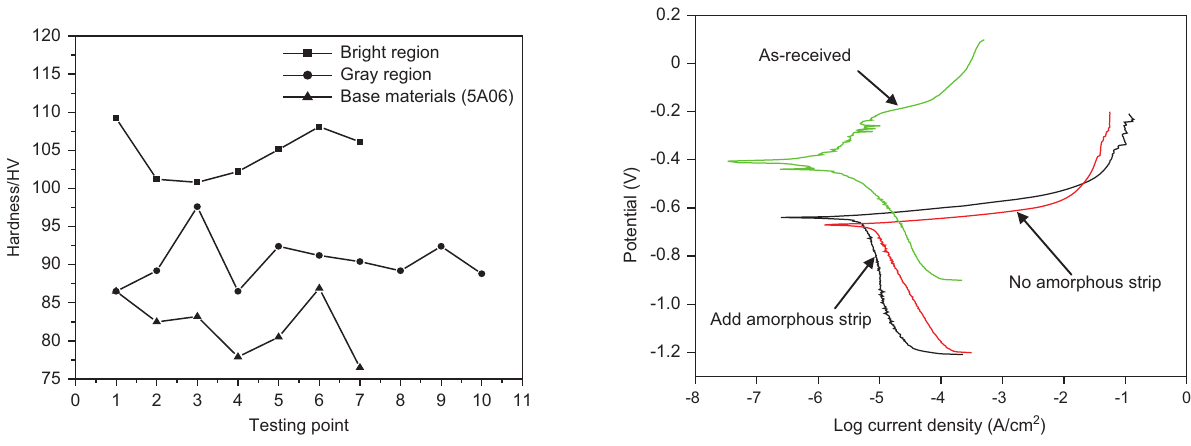
Figure 5 Polarization curves of the different specimens in a 3.5% NaCl solution. Scanning rate: 3